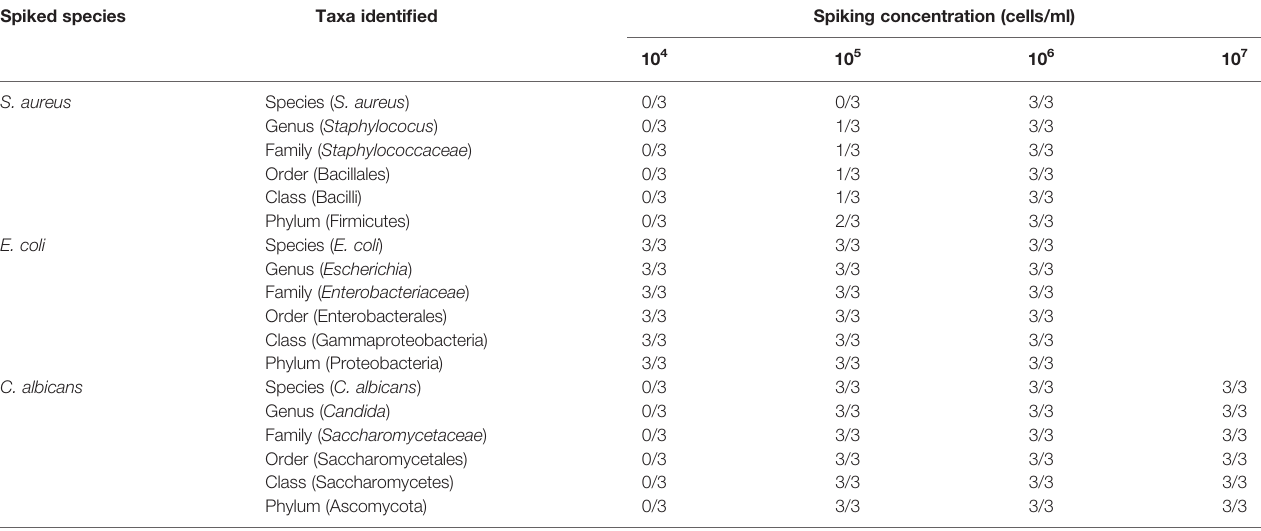
TABLE 2 | The sensitivity of the LC-MS/MS shotgun proteotyping protocol. Spiked species